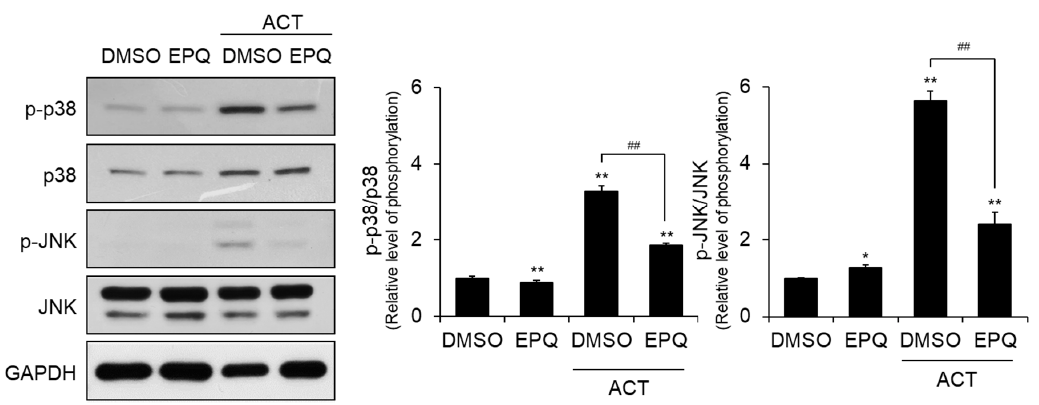
Figure 6. Inhibitory effect of EPQ on acetaldehyde-induced MAPK activation in PC12 cells. PC12 cells weretreatedwithDMSO(0.5%, v / v )orEPQ(20 µ M)inthepresenceandabsenceofacetaldehyde(500 µ M) for 24 h. The MAPK activation-related protein levels of the phosphorylated and non-phosphorylated forms of p38 MAPK and JNK were determined in the western blots. GAPDH was a loading control. All values are expressed as mean ± SEM ( n = 3; * p < 0.05, ** p < 0.01 compared to the DMSO control group and ## p < 0.01 compared to the group treated only with ACT). EPQ, ent -peniciherqueinone; DMSO, dimethyl sulfoxide; GAPDH, glyceraldehyde 3-phosphate dehydrogenase; p38, p38 mitogen-activated protein kinase; JNK, c-Jun N-terminal kinase; p,